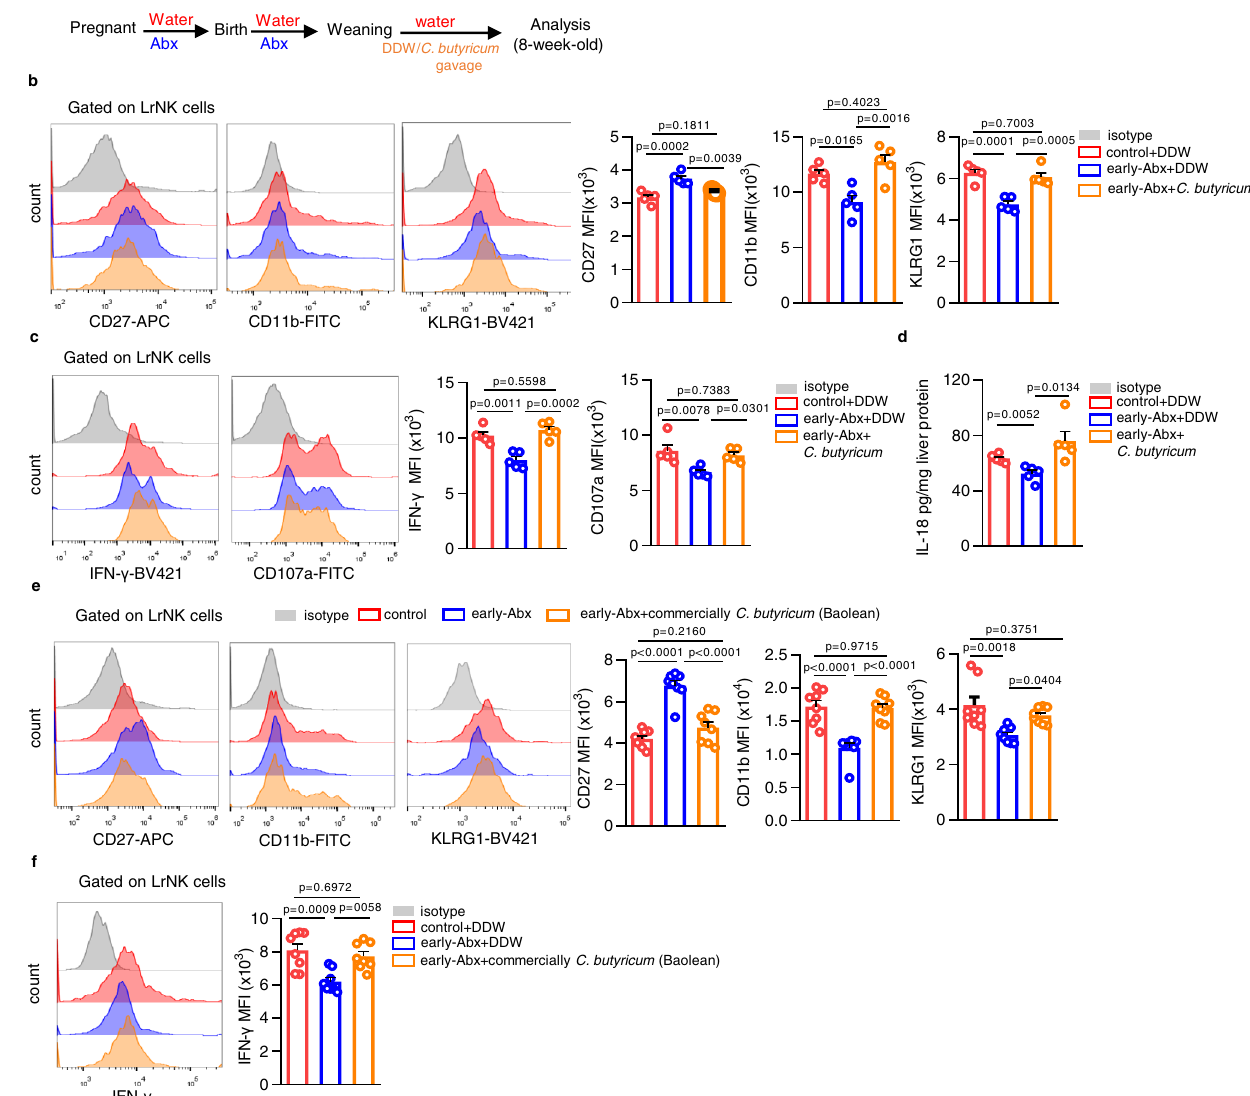
Fig. 8 | Dietary Clostridium butyricum rescues LrNK maturation impairment in early-Abx treated mice. a Experimental scheme of the Clostridium butyricum (C. butyricum)gavagemousemodel. b , c RepresentativeFACSplotsandbargraphfor the expression (MFI) of maturation markers and effector molecules in LrNK cells fromdifferentgroupsofmice( n =5pergroup). d ELISAassayofIL-18levelsinliver tissues from different groups of mice ( n =5 per group). e , f Representative FACS